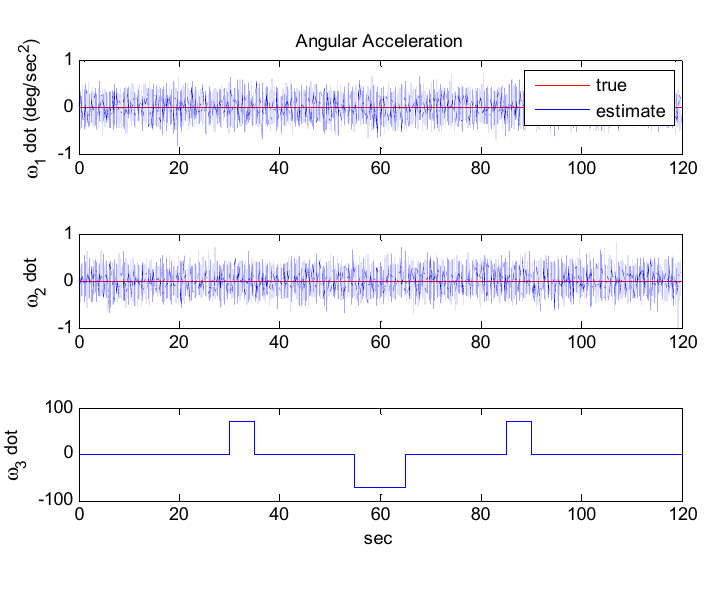
Figure 7. Angular acceleration: Case 2.